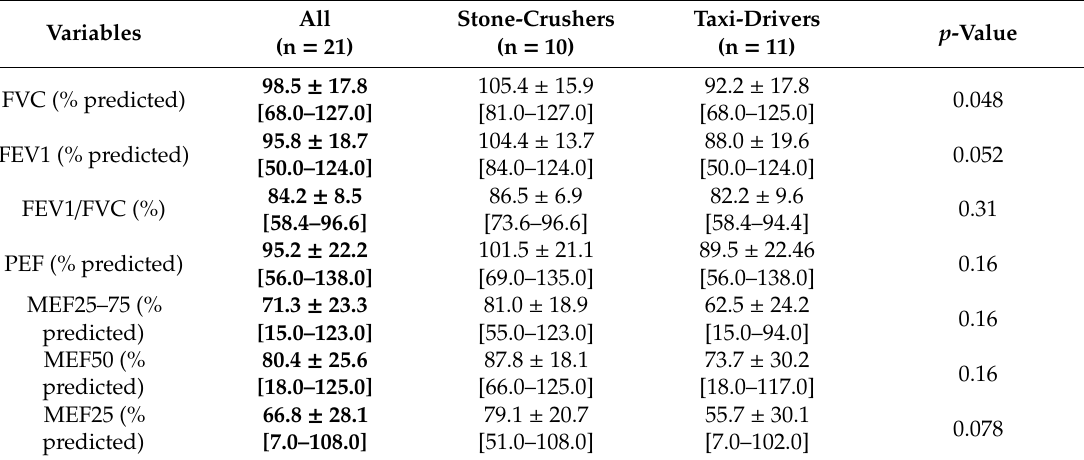
Table 5. Pulmonary Function Tests in stone-crushers and